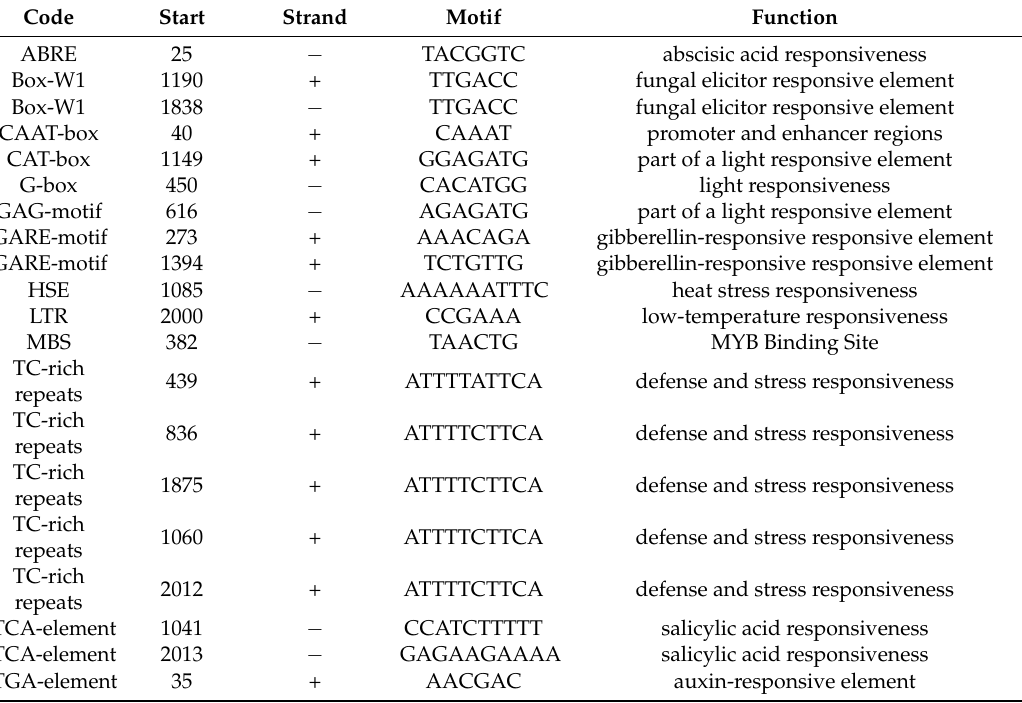
Table 1. The motif prediction of the OsIMP gene